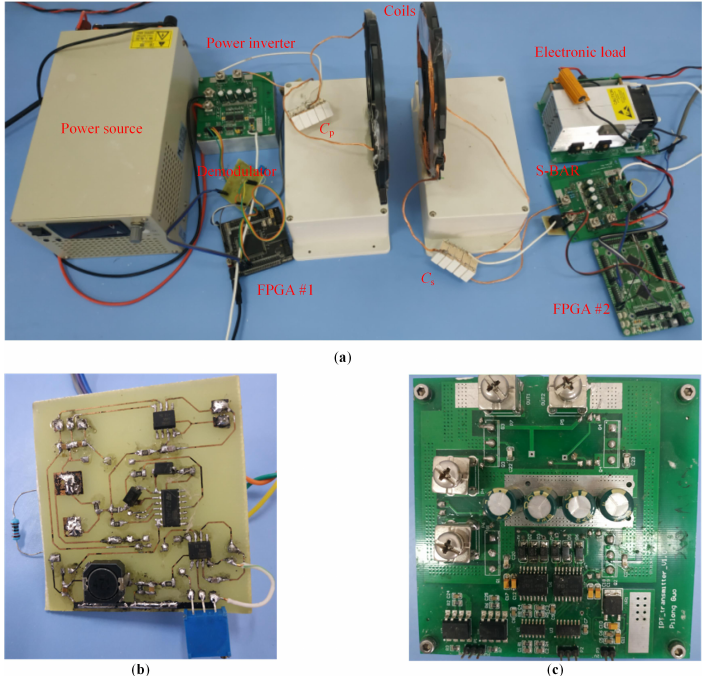
Figure 15. Photograph of the experimental prototype. ( a ) Overall configuration of experimental prototype. ( b ) Demodulator circuit. ( c ) S-BAR